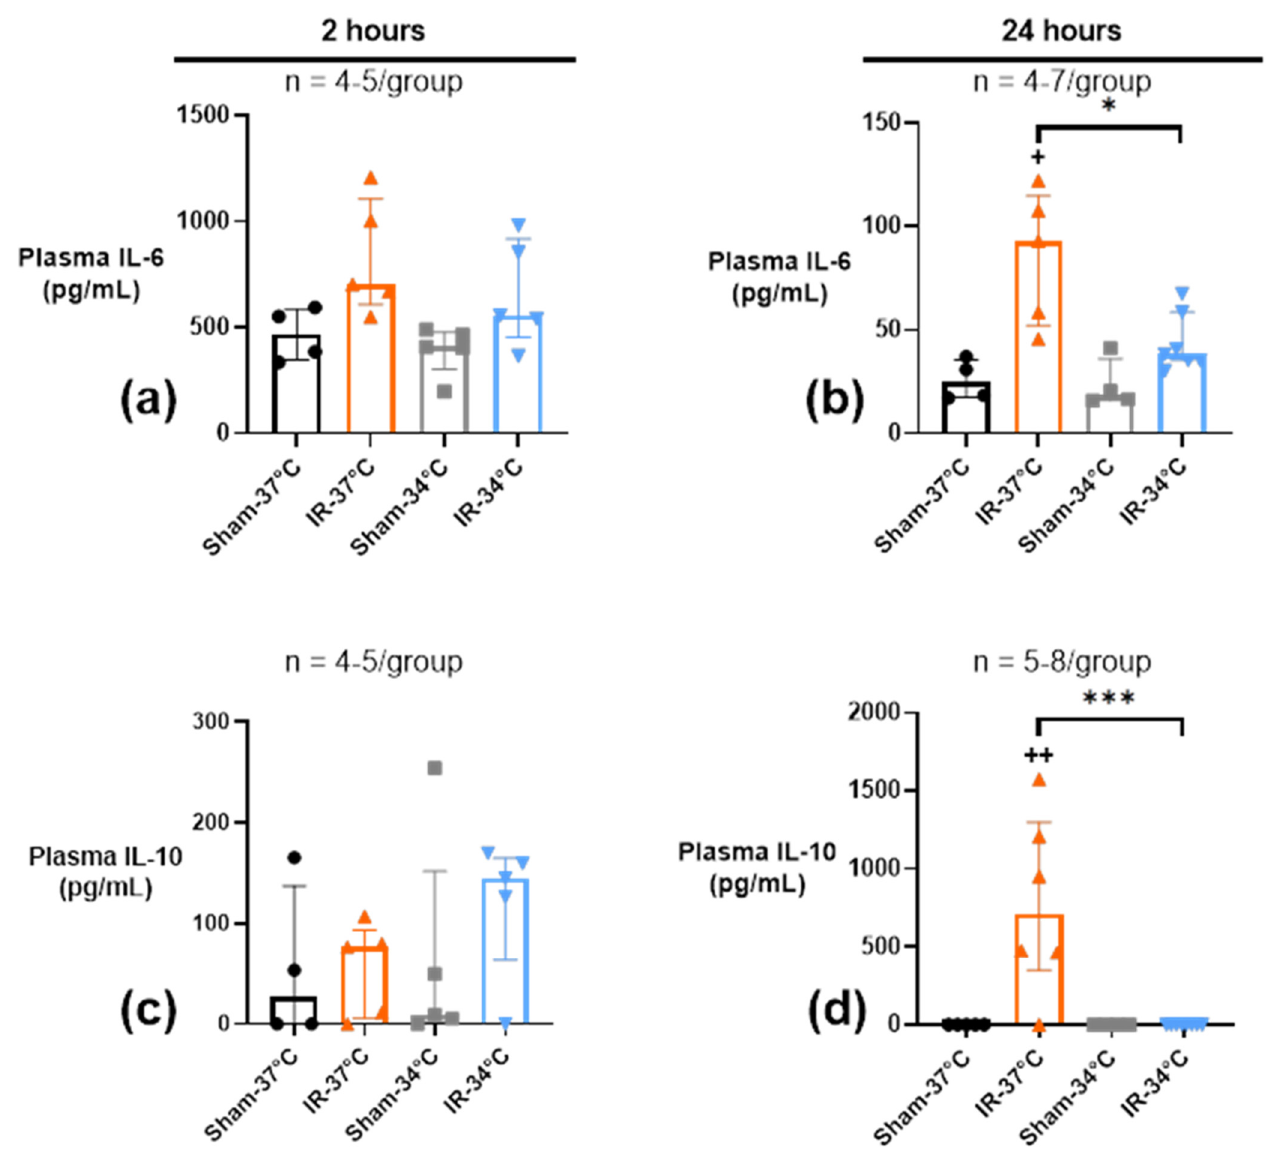
Figure 5. Plasmatic concentrations of inflammatory markers IL-6 ( a , b ) and IL-10 ( c , d ) after 20 min of bilateral renal ischemia where the mice body temperature was maintained at normothermia (IR-37 ◦ C) or at mild therapeutic hypothermia (mTH) (IR-34 ◦ C), and 2 h or 24 h of reperfusion, or after a Sham procedure with the same body temperature (Sham-37 ◦ C and Sham-34 ◦ C). IL-6 plasmatic level peaked 2 h after reperfusion in the IR-37 ◦ C group. At 24 h of reperfusion, IL-6 concentration was lower but still increased in IR-37 ◦ C, and reached a higher value than in IR-34 ◦ C group. IL-10 plasmatic level peaked at 24 h only in the IR-37 ◦ C group, with almost undetectable level in the IR-34 ◦ C group. Data are shown as median with interquartiles. * p < 0.05, *** p < 0.001, Mann–Whitney test. + p < 0.05, ++ p < 0.01 vs. Sham-37 ◦ C, Mann–Whitney test.